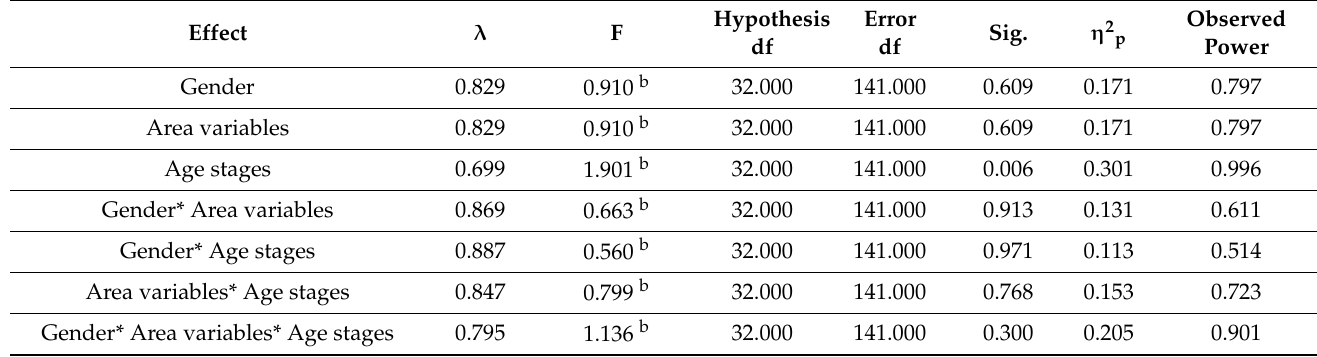
Table 6. The results of the Multivariate Tests (MANOVA)/F3—(preferred leisure